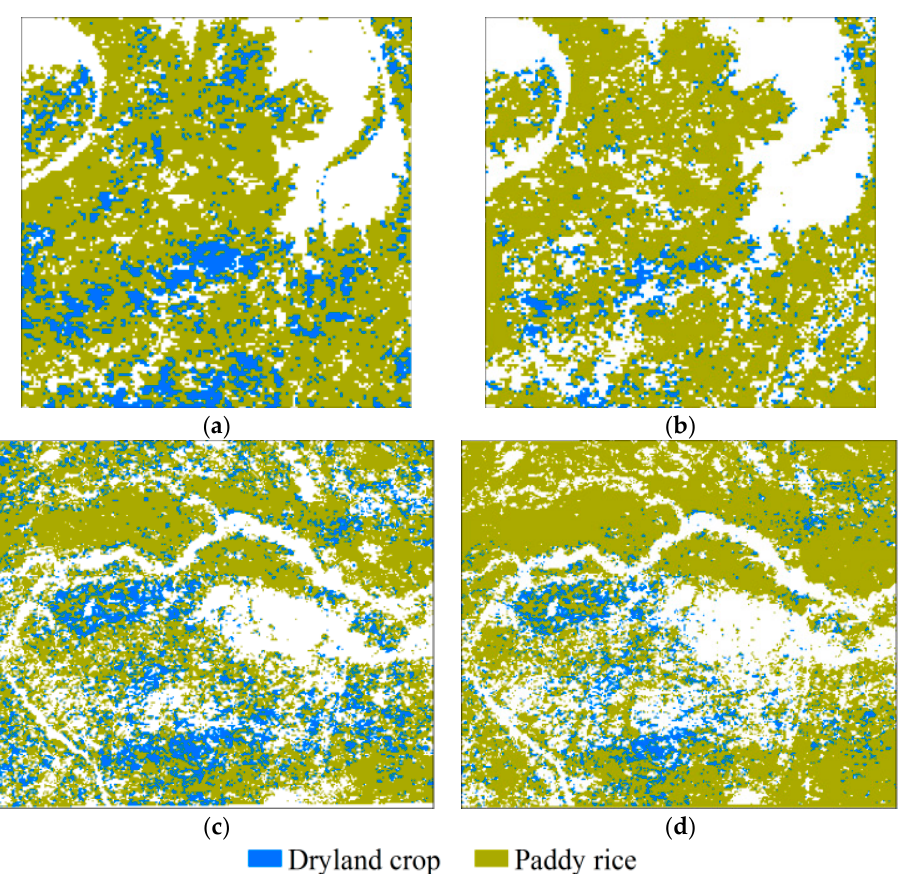
Figure 9. Cropland classification result using the original DTW distance and OLWDTW distance with the optimal enhance factor σ : ( a ) is the cropland distribution in test site 1 classified by original DTW distance; ( b ) is the cropland distribution in test site 1 classified by OLWDTW distance; ( c ) is the cropland distribution in test site 2 classified by original DTW distance; and ( d ) is the cropland distribution in test site 2 classified by OLWDTW distance.